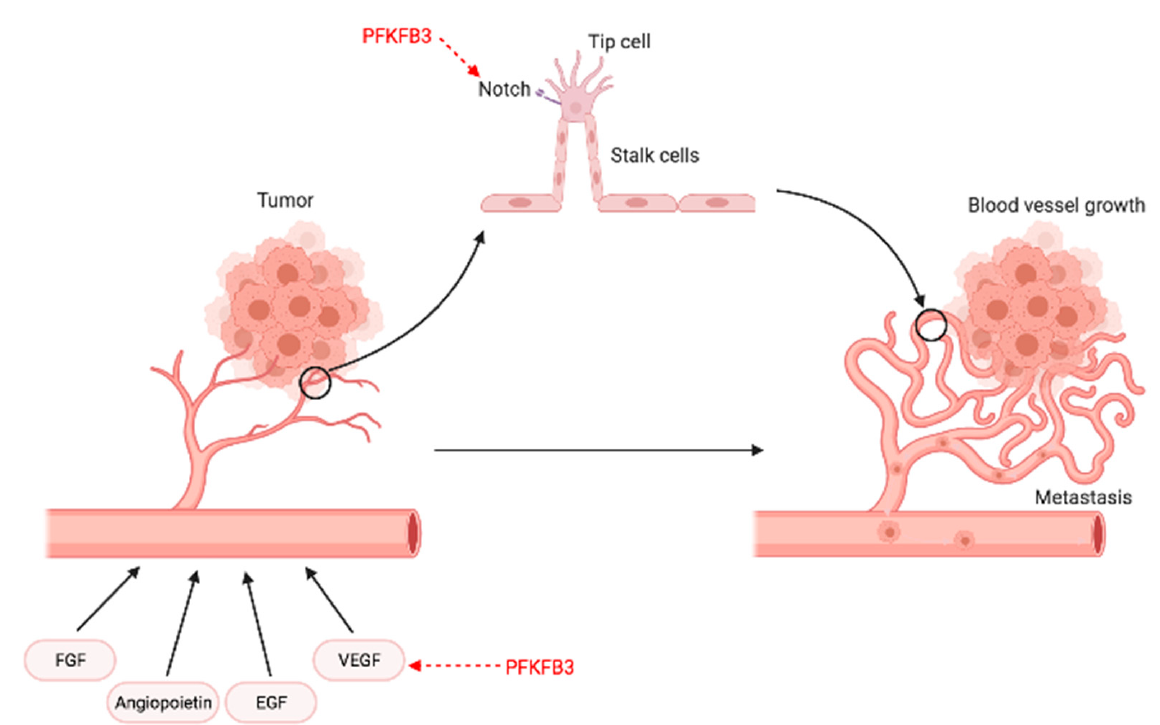
Figure 9. Schematic representation of angiogenesis, a process in which new blood vessels are developed from pre-existing vessels, allowing for tumor progression and metastasis. During angiogenesis, vascular permeability is increased in the existing vessels, which allows for extravasation, degradation of the extracellular matrix, and release of sequestered growth factors. When exposed to stimulating factors (such as VEGF, FGF, and EGF), endothelial cells proliferate, migrate, and form primary sprouts. Vessel sprouting by migrating tip and proliferating stalk cells is controlled by genetic signals, such as Notch. Further proliferation, followed by the synthesis of a new basement membrane and maturation, leads to assembly of lumen-bearing cords. PFKFB3 levels affect angiogenesis through mediating VEGF activity, where PFKFB3 upregulation results in enhanced VEGF activity. Moreover, silencing of PFKFB3 impairs angiogenesis, while PFKFB3 overexpression overrules the pro-stalk activity of Notch. Abbreviations: FGF—fibroblast growth factor, EGF—endothelial growth factor, VEGF—vascular endothelial growth factor. Created with BioRender.com.